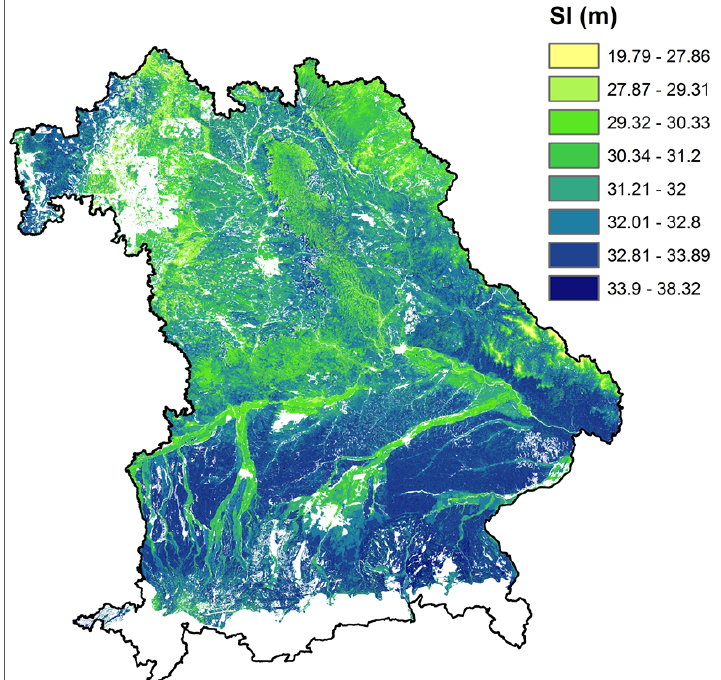
Figure 9. Modeled SI for Bavaria (Alps are